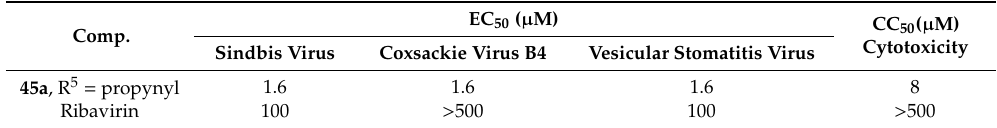
Table 18. The antiviral activity of the C-5-alkynyl uracil ASA derivative. Comp.